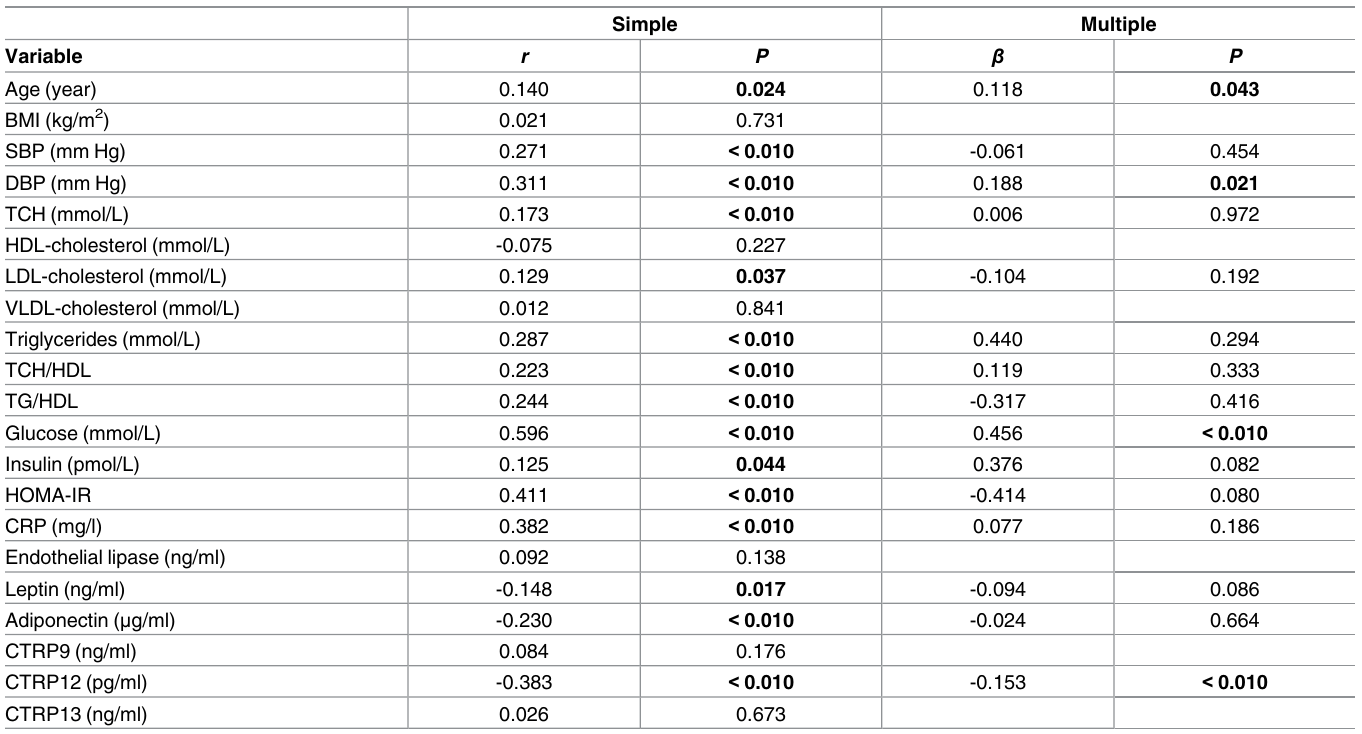
Table 3. Linear regression analysis of variables associated with CTRP1 ( n = 262).